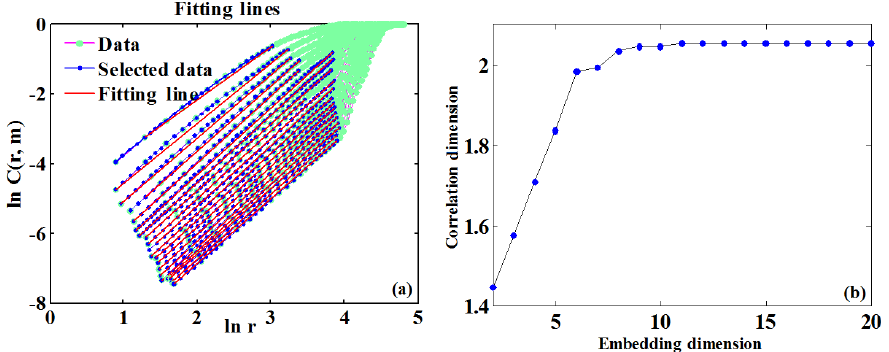
Figure 5. The final fitted lines and the correlation dimension of the Lorenz system: (a) the final fitted lines through the scaling regions and (b) correlation dimensions as a function of embedding